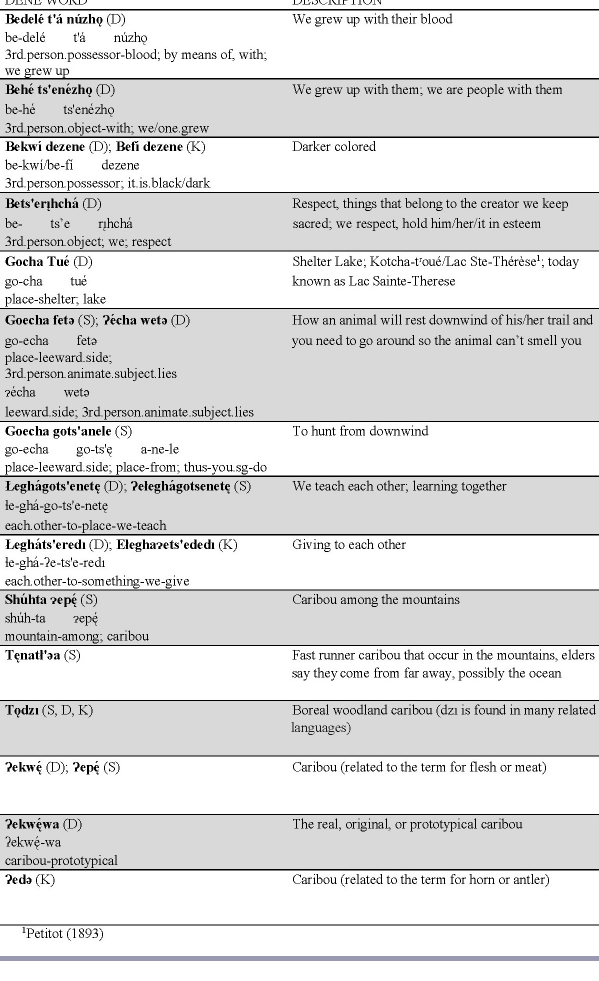
Fig. 2 . Word descriptions and definitions in the Shu ́ hta (S), Sahtu ́ /De ́ lı ̨ ne ̨ (D), and K'a ́ hsho (K) dialects of the North Slavey language in the Sahtú region of the Northwest Territories,